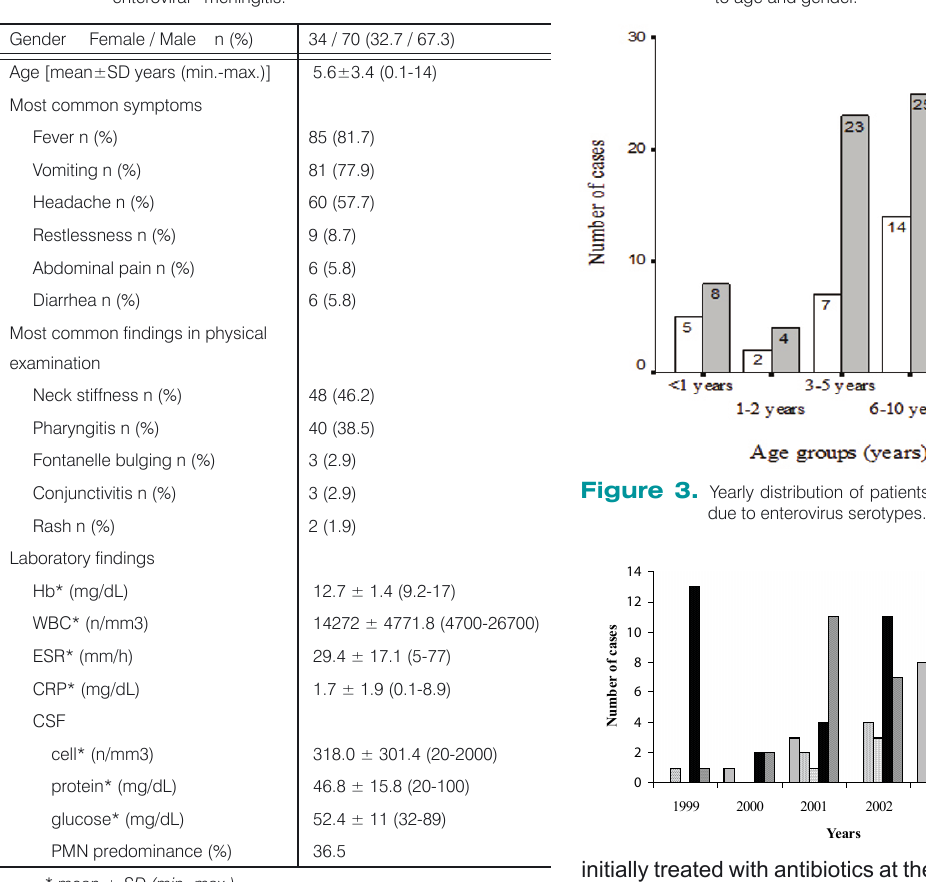
Figure 2. Distribution of enteroviral meningitis patients according to age and gender.